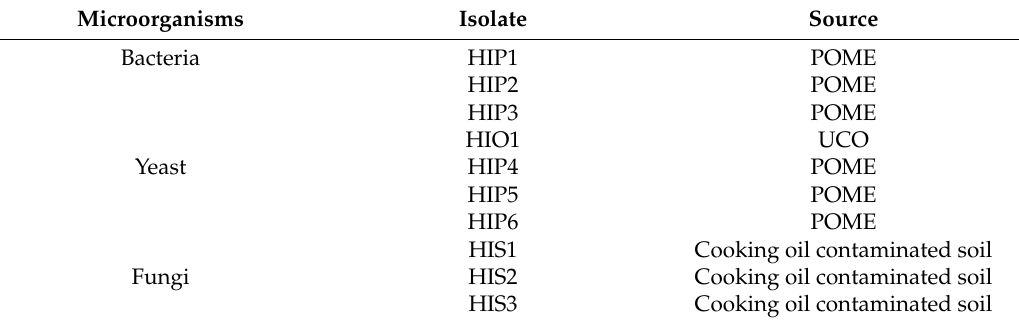
Table 1. Microorganisms screened using Bushnell and Haas